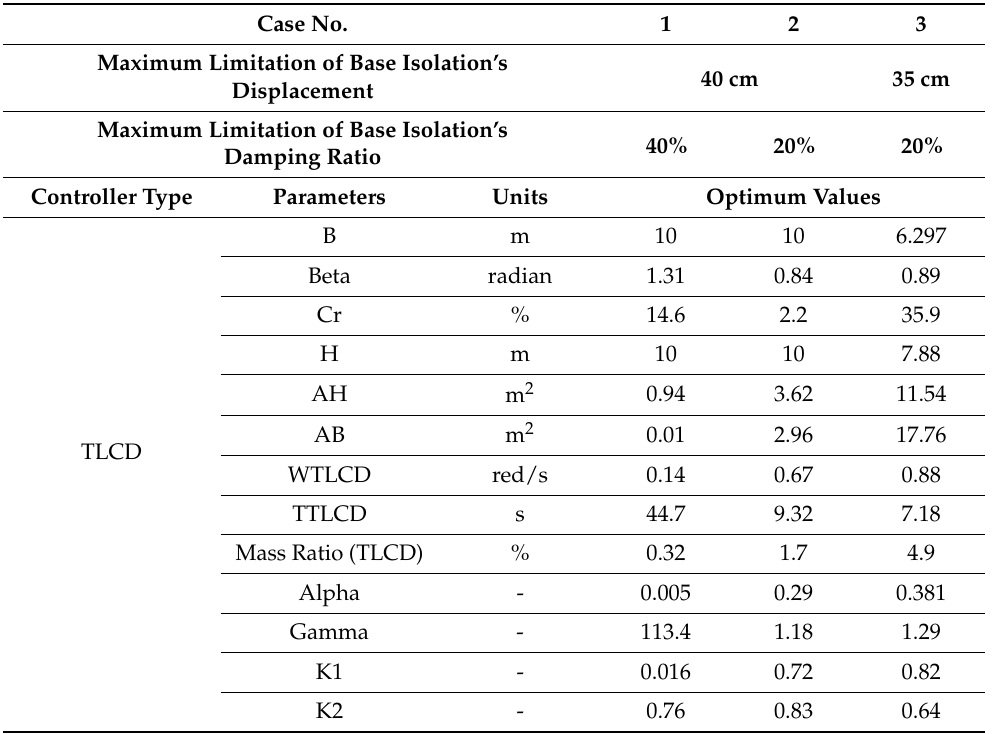
Table 6. Properties of optimized TLCD